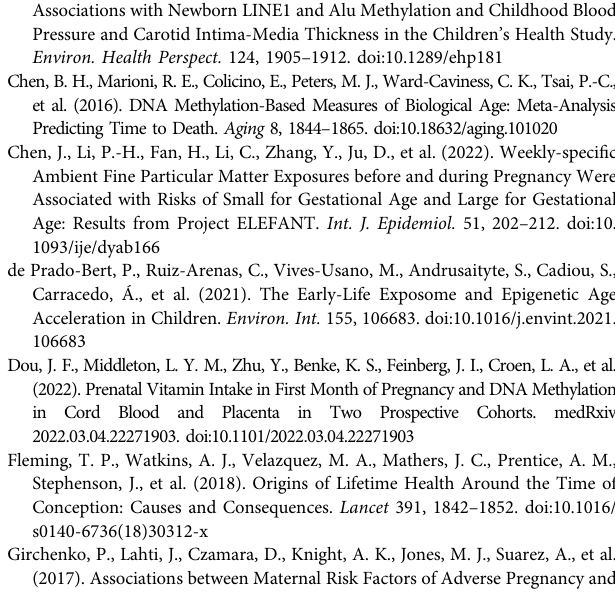
represent the interquartile ranges for air pollutants. The horizontal black line dividing the box represents the median. Supplementary Figure S2 | Box and whisker plots of ambient air pollutants by region. Box and whisker plots showing the distribution of (A) NO 2 (B) O 3 (C) PM 2.5 (D) PM 10 for preconception, trimester 1, trimester 2, trimester 3, and pregnancy by region. The boxes represent the interquartile ranges for air pollutants. The horizontal black line dividing the box represents the median. Two-tailed t-tests were used to compare the differences of each pollutant by region with the following symbols indicatingp-value(ns:p > 0.05, p :p < =0.05,: pp p < =0.01, ppp :p < =0.001, pppp :p < = 0.0001). Supplementary Figure S3 | Correlation between air pollutants. Darker shades represent stronger correlations. Blue shades indicate positive correlations, while red shades indicate negative correlations, as outlined in corresponding key. Abbreviations: NO2, Nitrogen Dioxide; NOx, Nitrogen Oxides; O3, Ozone; PM2.5, Particulate Matter < 2.5 μ m; PM10, Particulate Matter < 10 μ m. Supplementary Figure S4 | Correlations between epigenetic age and gestational age atbirth.Scatterplotsshowingthecorrelationof (A) epigenetic age estimated by Knight et al. (B) epigenetic age estimated by Bohlin et al. with the smooth line and 95% con fi dence interval. The correlation coef fi cient represents the spearman coef fi cient. Supplementary Figure S5 | Distributed lag models results for NO 2. β coef fi cients and 95% con fi dence intervals from distributed lag models (DLMs) are shown for associations between (A) NO 2 and epigenetic age acceleration estimated by Knight et al. (B) NO 2 and epigenetic age acceleration estimated by Bohlin et al. at each week of preconception and pregnancy. All models were adjusted for child sex, maternal race/ethnicity, maternal education, year of birth, and region of the participant at recruitment. The β coef fi cient represents the difference in epigenetic age acceleration for a 10-unit difference in the pollutant. Epigenetic age acceleration was de fi ned as the residual of epigenetic age estimated by Knight clock or Bohlin clock on gestational age at birth adjusted for cell heterogeneity. SupplementaryFigureS6| DistributedlagmodelsresultsforO 3. β coef fi cientsand 95% con fi dence intervals from distributed lag models (DLMs) are shown for associations between (A) O 3 and epigenetic age acceleration estimated by Knight et al. (B) O 3 and epigenetic age acceleration estimated by Bohlin et al. at each week ofpreconception and pregnancy. All models were adjusted for child sex, maternal race/ethnicity, maternal education, year of birth, and region of the participant at recruitment. The β coef fi cient represents the difference in epigenetic age acceleration for a 10-unit difference in the pollutant. Epigenetic age acceleration was de fi ned as the residual of epigenetic age estimated by Knight clock or Bohlin clock on gestational age at birth adjusted for cell